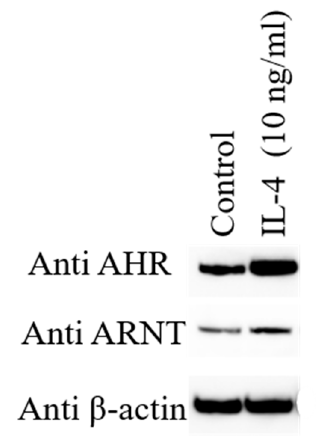
Figure 2. Human epidermal keratinocytes are stimulated with 10 ng/mL of IL-4 augments the protein expression of aryl hydrocarbon receptor (AHR) and AHR-nuclear translocator (ARNT) compared with untreated control by Western blot analysis.